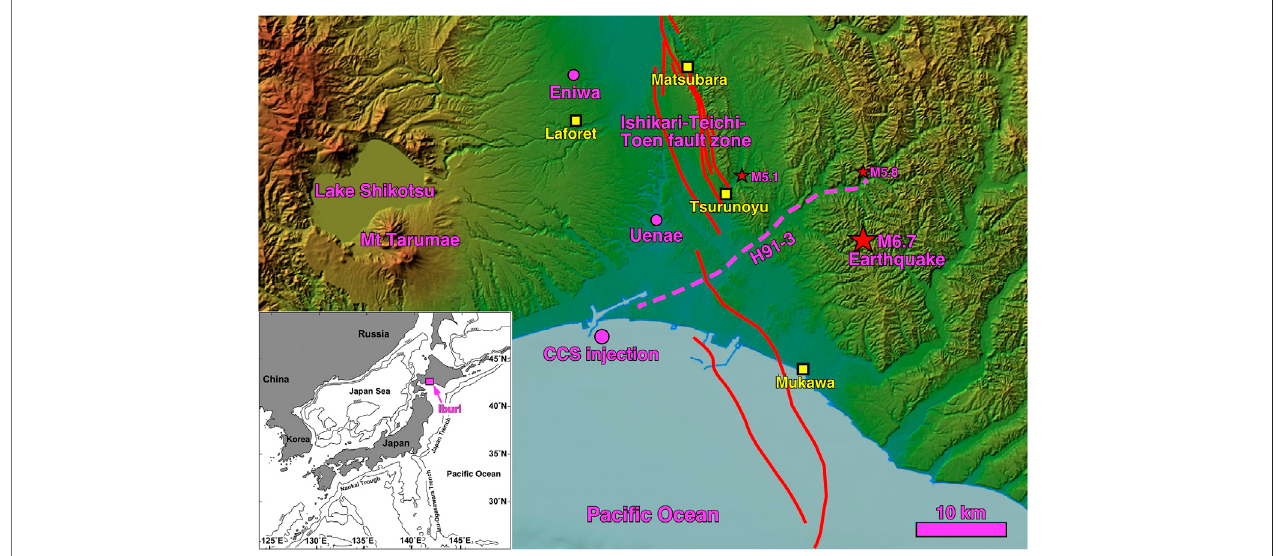
FIGURE 1 | Location of Uenae and Eniwa sampling wells in the Hokkaido Iburi region; the CCS-CO 2 injection point (purple dots); and main shock epicenter (M6.7) of the 2018 Hokkaido Eastern Iburi earthquake (red star). Two additional red stars denote the epicenters of the M5.1 earthquake on July 1 st , 2017 and of the largest (M5.8) aftershock on February 21 st , 2019. The red lines represent active faults in the Ishikari-Teichi-Toen fault zone (ITTFZ). The purple dashed line denotes the seismic re fl ection transect H91-3. Yellow squares show hot springs sampled for helium isotopes. The inset map shows the location of the Iburi region in Hokkaido, Japan.